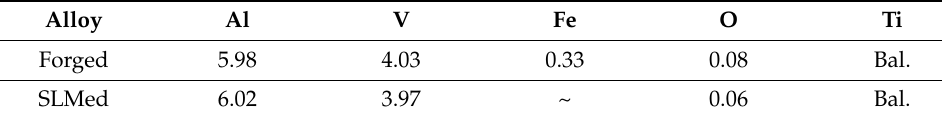
Table 1. Chemical composition of the two tested Ti-6Al-4V alloys (wt.%). Alloy Al V Fe O Ti Forged 5.98 4.03 0.33 0.08 Bal. SLMed 6.02 3.97 ~ 0.06